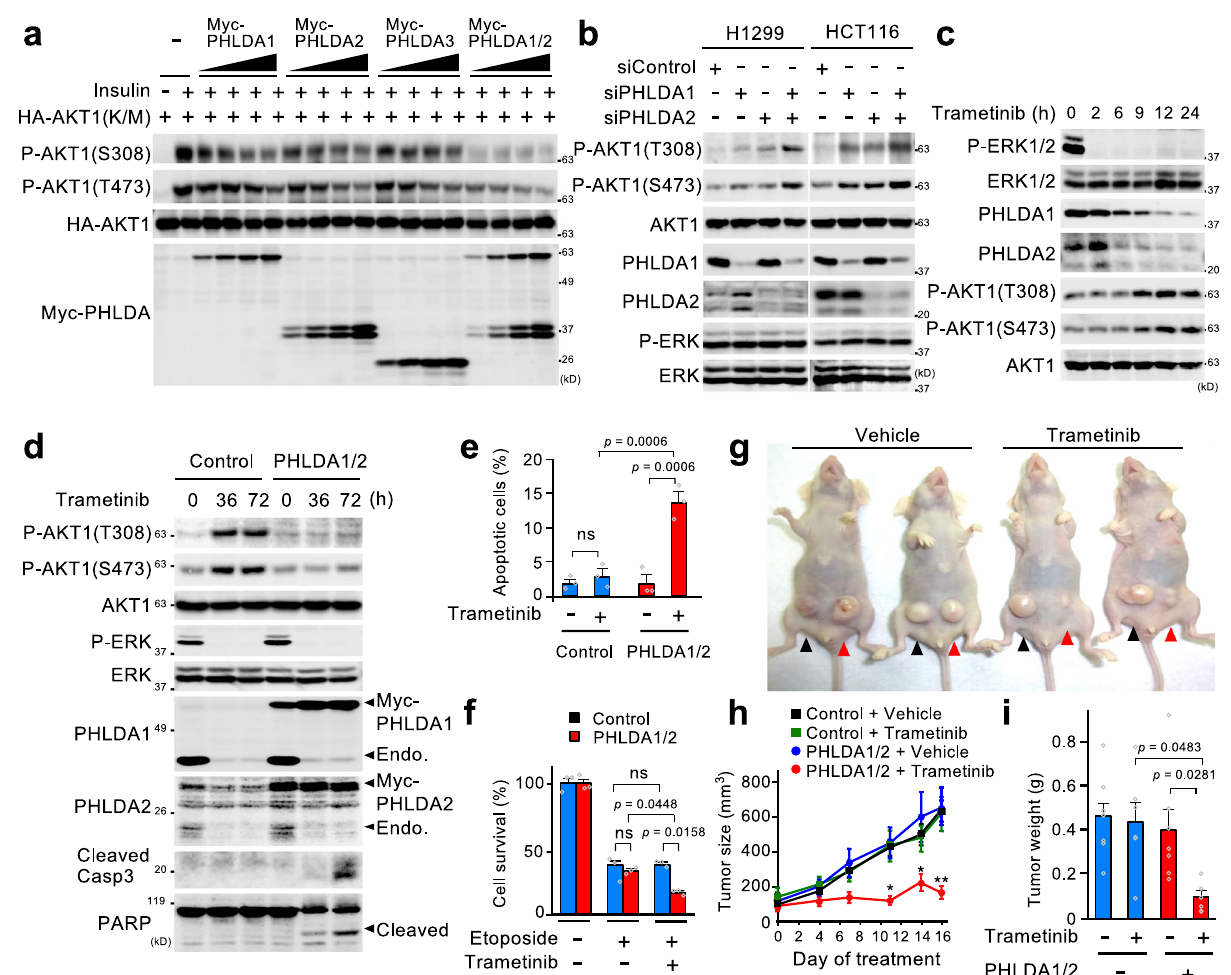
Fig. 9 PHLDA1/2 mediate cancer-speci fi c ERK-AKT crosstalk and impact on the drug-sensitivity of tumor cells. a Simultaneous expression of PHLDA1/ 2 is critical for ef fi cient inhibition of AKT. HEK293 cells were transfected with inactive HA-AKT1(K/M), together with Myc-PHLDA1 and/or 2, or 3 as indicated. The cells were treated with insulin for 10 min, and the cell lysates were probed for AKT1 phosphorylated at T308 and S473 and for protein levels. b H1299 and HCT116 cells were transfected with siRNAs targeting PHLDA1 and/or PHLDA2. Expression levels of PHLDA1/2, the phosphorylation states of AKT and ERK, and their protein levels were analyzed by immunoblotting. c , d Trametinib-mediated PHLDA1/2 downregulation activates AKT. H1299 cells ( c ), and those stably expressing Myc-PHLDA1/2 or empty vector (control) ( d ) were treated with trametinib for the indicated times. Immunoblotting was performed as in b . In ( d ), apoptosis was monitored by immunoblotting of cleaved-caspase 3 and PARP. e The indicated cells were treated with trametinib (10 μ M) for 72 h, and apoptosis was detected by annexin V staining. f The indicated cells were cultured with etoposide (1 μ M) with or without trametinib (10 μ M) for 4 days. The cell survival rate was determined by CCK8 assay. e , f Data are mean ± SEM ( n = 3). P -values were assessed using one-way ANOVA followed by Tukey ’ s multiple comparisons test. ns, not signi fi cant. g – i H1299 control cells (black arrowheads) and H1299-PHLDA1/2 cells (red arrowheads) were transplanted into the left and right fl anks of mice, respectively. Mice were then treated with vehicle or trametinib (3 mg/kg, 3 times a week) by oral gavage. g Representative images of the mice on day 16. h The growth curve of the xenograft tumors. i The weight of excised xenograft tumors on day 16 (vehicle, n = 7; trametinib, n = 6). Data are mean ± SEM. P -values were assessed using two-tailed Student t-test ( h ) or using